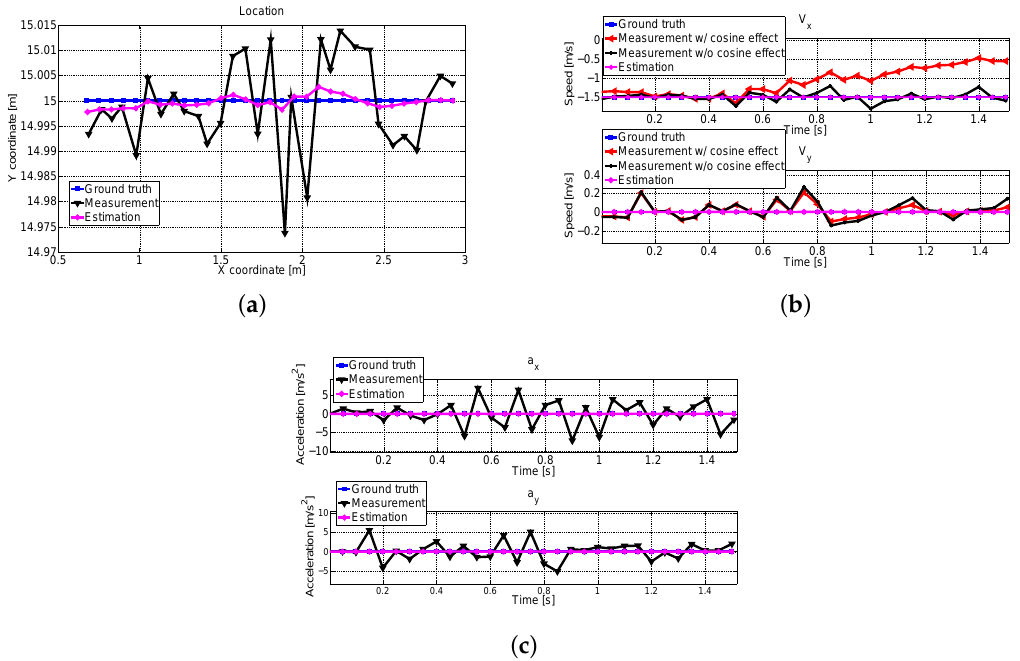
Figure 11. The received measurement and estimated trajectory about pedestrian at V1: ( a ) Position comparison. ( b ) Measured and estimated velocities about x and y axes with and without cosine effect compensation. ( c ) Comparisons of the calculated acceleration (direction).